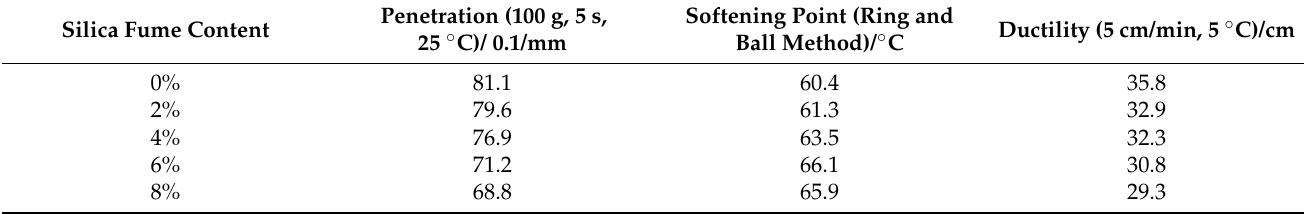
Table 3. Three major indices of the silica fume/ styrene-butadiene-styrene composite-modified asphalt with different silica fume contents before aging.